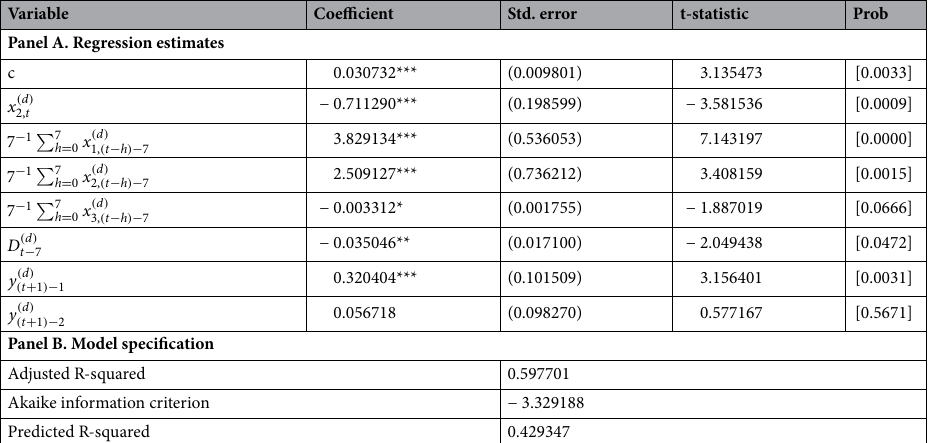
Table 5. Heterogeneous autoregressive model with explanatory variables AR ( 2 ) − H X for the daily deaths to daily cases ratio. ***, **, and * denote statistical significance at 1%, 5%, and 10%, respectively. Bootstrapped coefficient estimates and standard errors via 2000 repetitions. The final optimal number of days (w) are selected according to the Akaike information criterion. The variance inflation factor (VIF) is used in order to deal with multicollinearity issues among the regressors. Regressors with values of VIF higher than 5 are excluded from the estimation analysis.